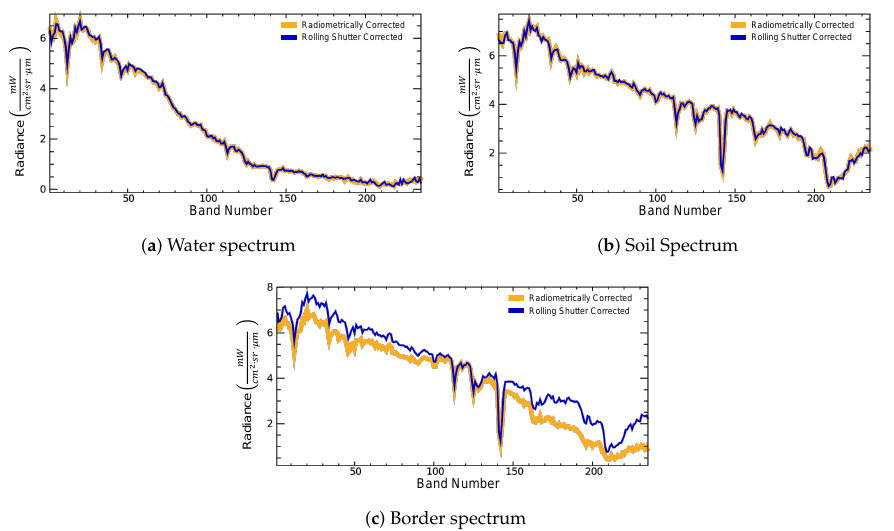
Figure 18. Intermediate DESIS L1B product spectra from the Region B defined in Figure 17. The effect of the correction on homogeneous pixels is negligible, as shown in ( a , b ). In ( c ), the effect of the rolling shutter correction is more visible, because for some bands the instrument captured a different